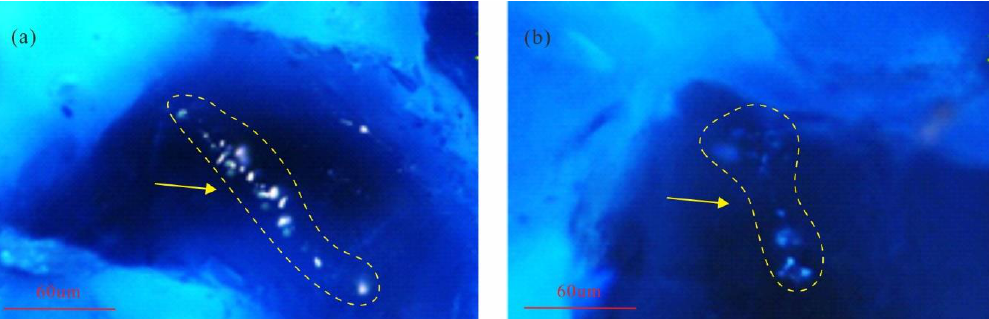
Figure 7. Characteristics of fluid inclusions in Hutubi anticline. ( a ) Fluorescent inclusion, well Dafeng 1, J 3 k, 7114 m, fluorescent thin section. The gas – liquid ratio is about 5%, which is used for early crude oil filling. ( b ) Fluorescent inclusion, well Dafeng 1, J 3 k, 7116 m, fluorescent thin section. The gas – liquid ratio is about 60 – 80%, which is the late condensate gas filling.